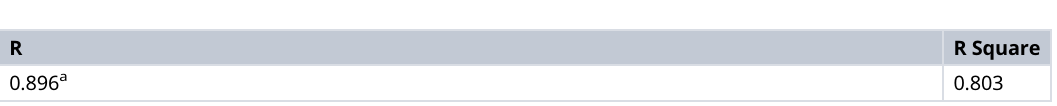
Table 6. Coefficient of